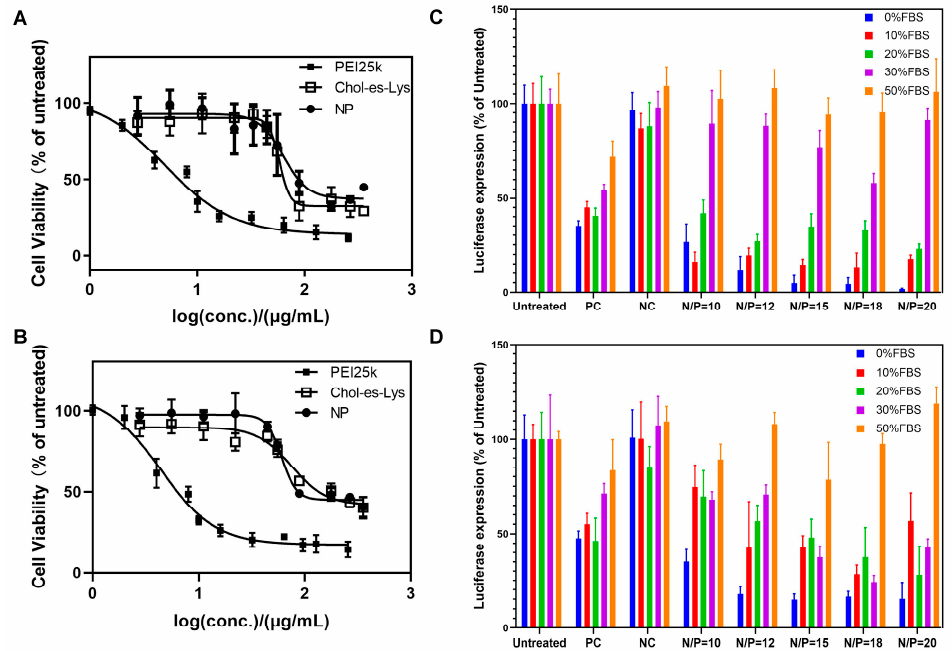
Figure 3. Transfection safety and performance of the cationic cholesterol derivative Chol-es-Lys and Chol-es-Lys/siRNA nanocomplexes. Cytotoxicity was evaluated with various concentrations (0–350 µ g/mL) in ( A ) H1299–Luc cells and ( B ) HeLa–Luc cells. The groups treated with no